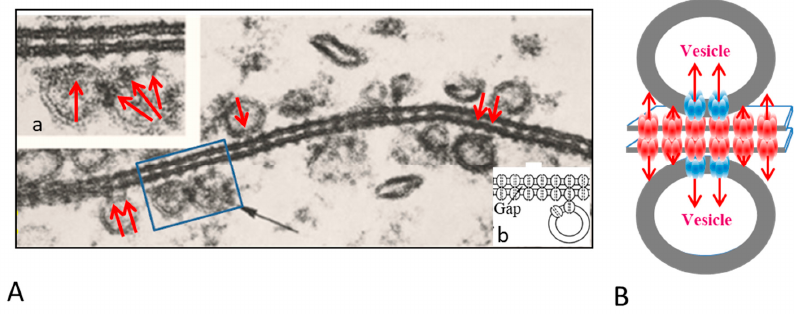
Figure 1. A . Electron micrograph showing the profile of a gap junction between crayfish lateral giant axons ( A ). The membranes display a beaded profile created by particles (innexons) that are in register, protrude from both membrane surfaces and bind to each other across the extracellular gap ( A ). The membranes are coated with 500–800 Å vesicles ( A , black arrow) whose membrane also contains particles ( A , red arrows), similar to junctional particles that often come in direct contact with junctional particles ( A and insets a and b). Occasionally, neighboring vesicles appear to bind to each other via particle–particle interactions ( A , inset a). The vesicles may directly communicate with each other and with vesicles lining on the other side of the junction ( B ). A from [9]. Int. J. Mol. Sci. 2020 , 21 , x FOR PEER REVIEW